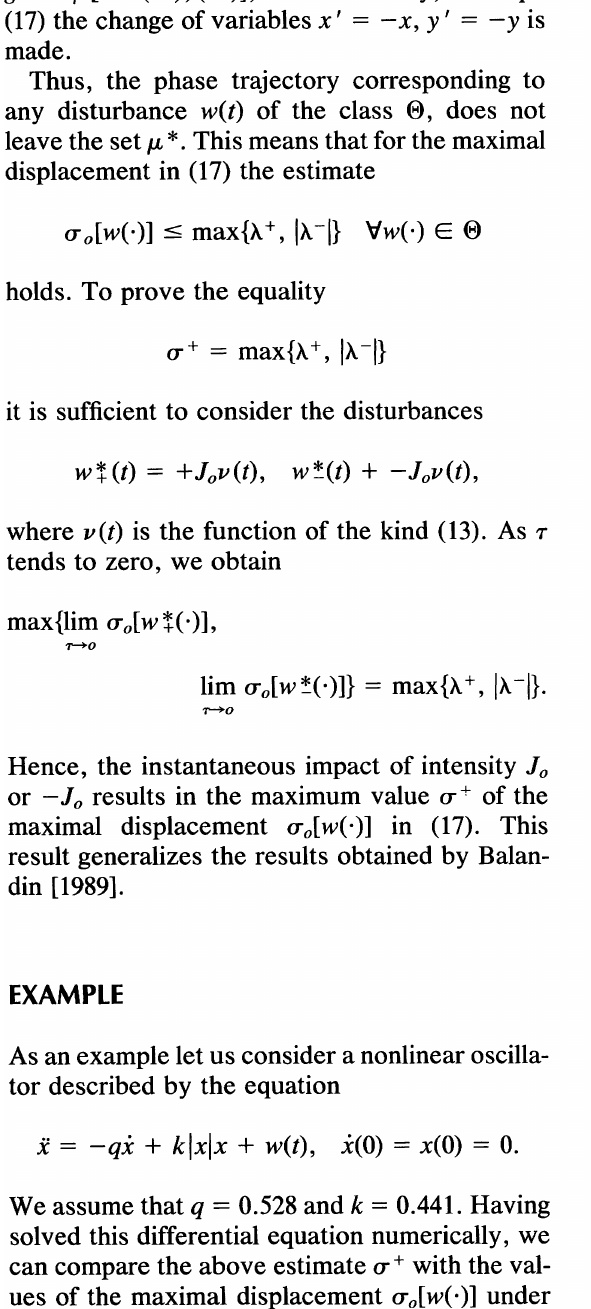
Table 1. Maximal Displacement